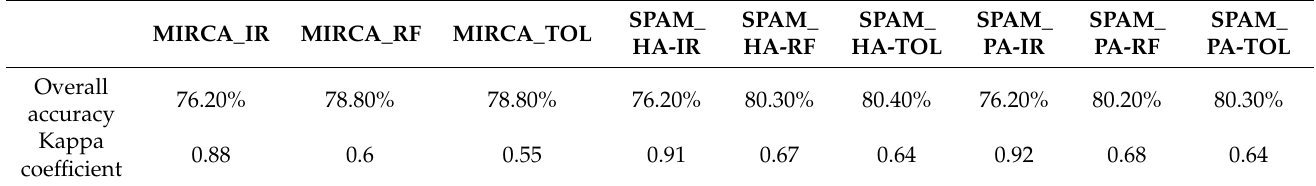
Table 3. Accuracy of evaluating land parcels as suitable for maize as judged by past data.